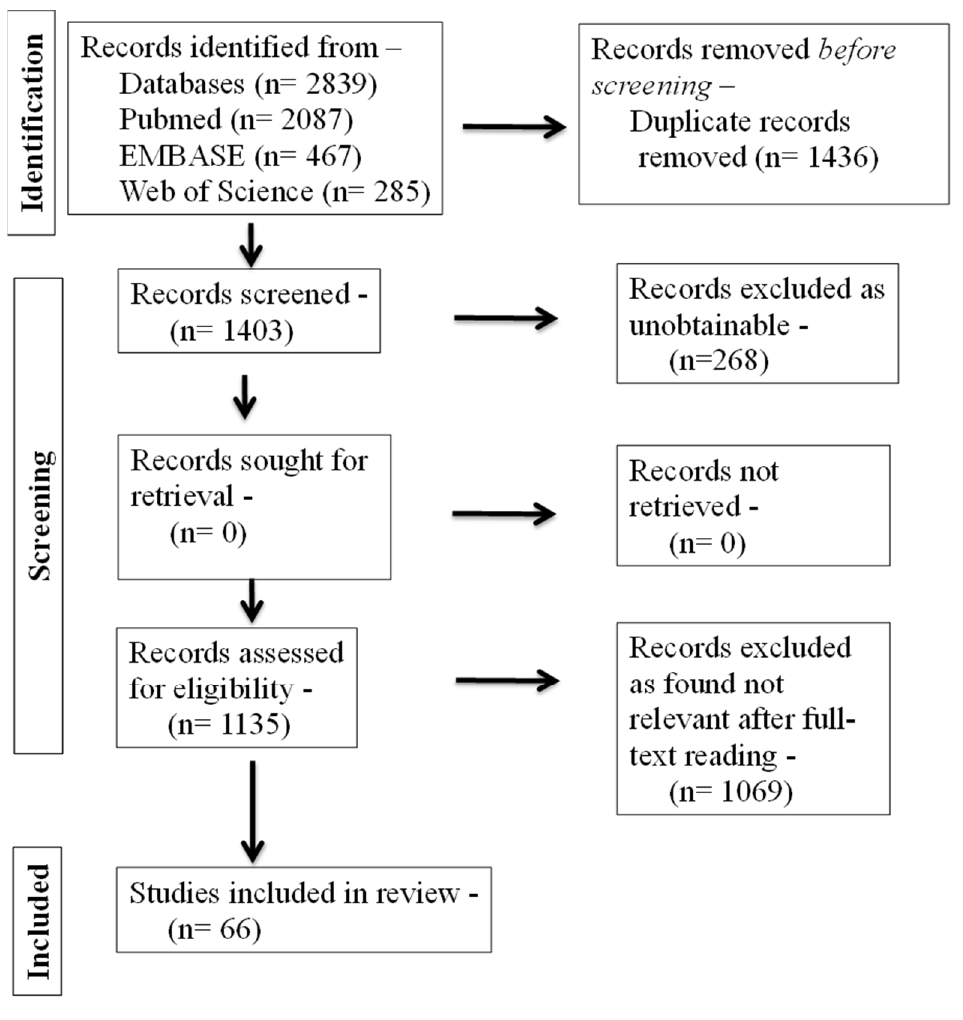
Figure 1. PRISMA flowchart of study selection process.